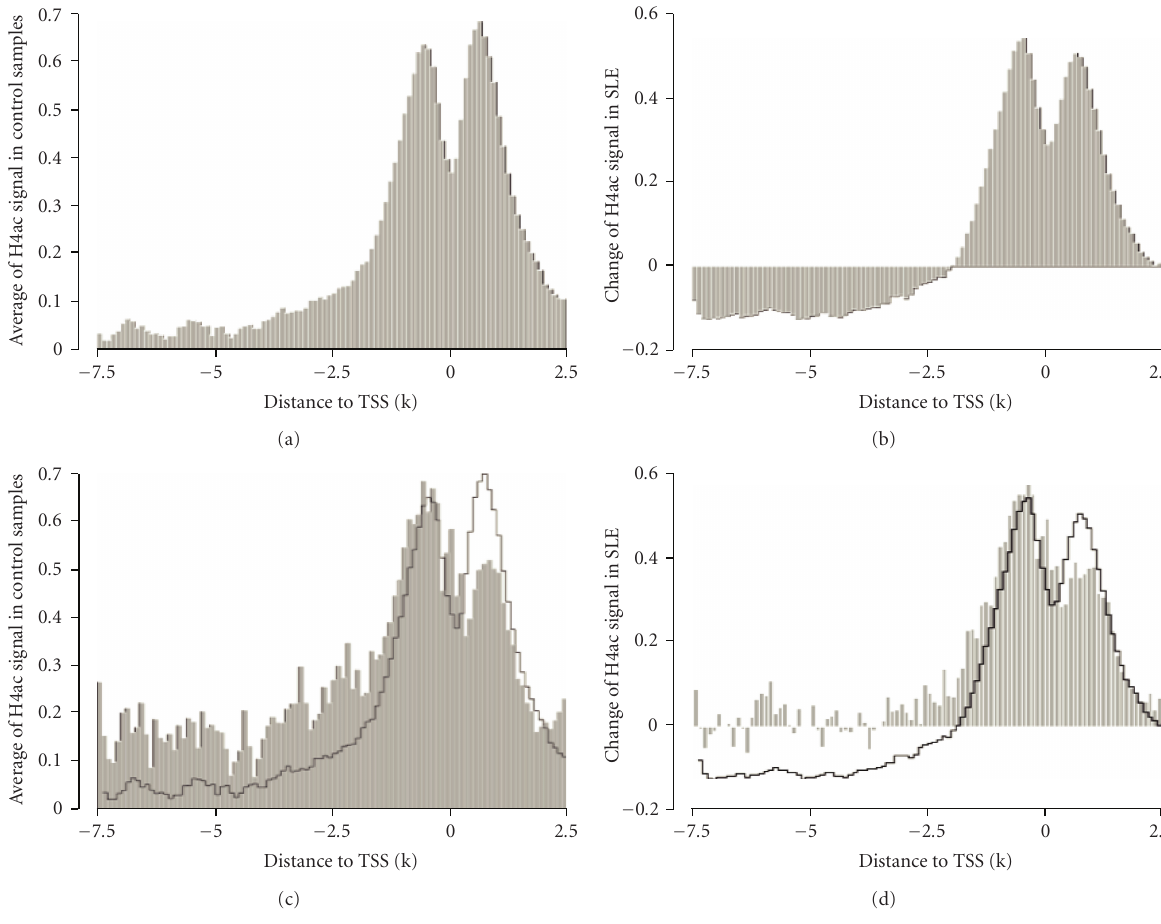
Figure 3: The distribution of H4ac at the promoter. (a) H4ac was distributed around the transcription start site. (b) The SLE monocytes had increased H4ac globally around the transcription start site. (c) The average of H4ac at potential TFBSs (grey area) was di ff erent from the general pattern of H4ac around TSS (black line), most notably, it was higher in the promoter region, but lower immediately after the TSSs. (d). In SLE, the average change of H4ac at potential TFBS (grey area) was also di ff erent from the general pattern (black line).